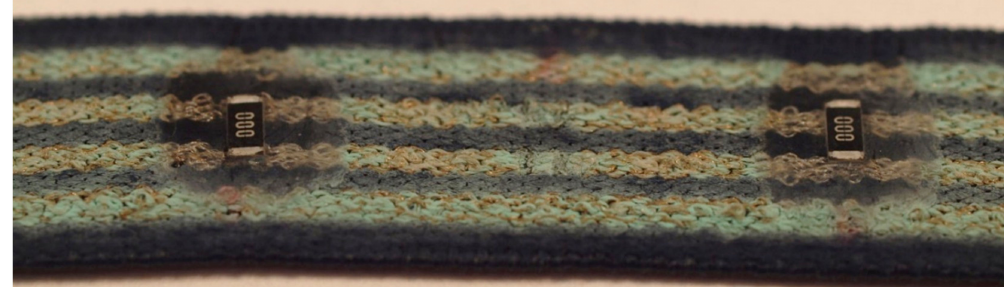
Figure 9. Example of a soldered sample after aging by artificial